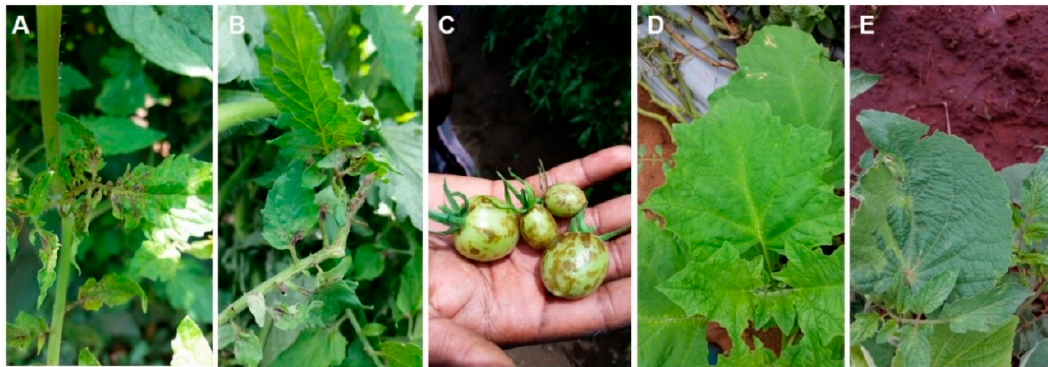
Figure 1. Tomato crops and nearby weed species exhibiting virus-like symptoms. ( A ): Necrotic spots beginning at the base of young leaves. ( B ): Vertical stem necrosis. ( C ): Necrotic spots and fruit deformation. ( D ): Chlorosis, necrotic spots, stunted growth, and linear chlorotic spots along the veins of Datura stramonium . ( E ): Stunting, chlorosis, and leaf deformation symptoms on the arable weed Abutilon grantii growing among tomato field crops in the northern KwaZulu Natal